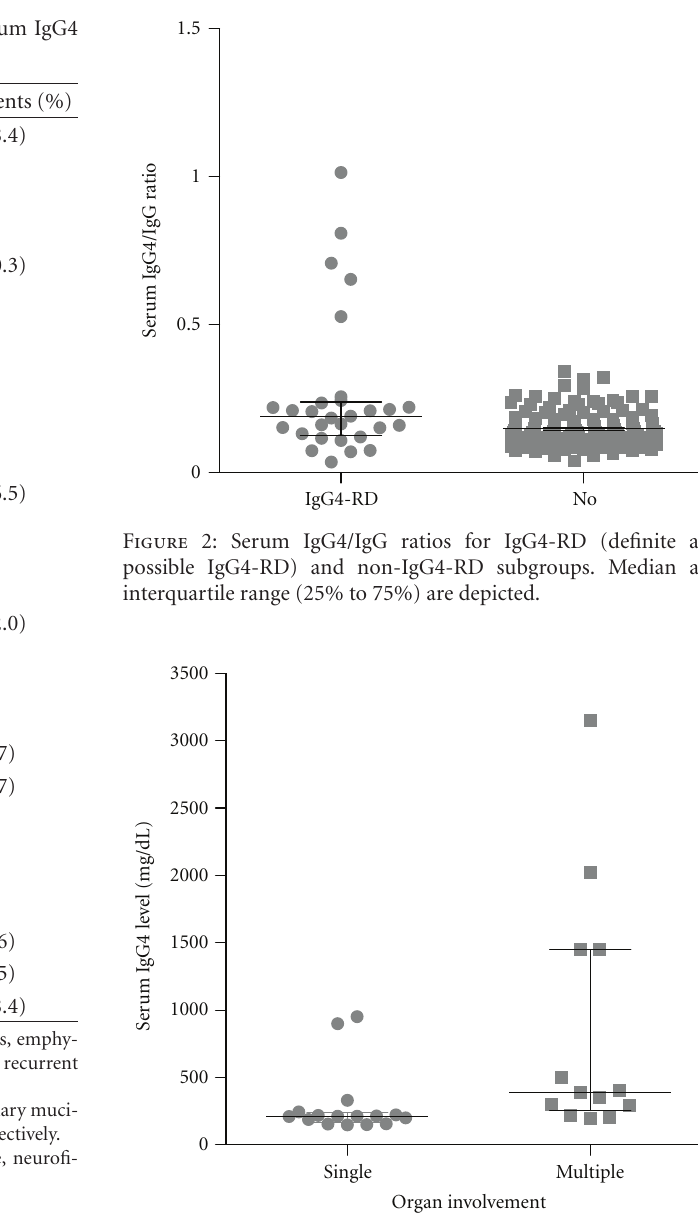
Figure 3: Serum IgG4 levels for patients with single-organ and multiple-(two or more) organ involvement. Median and interquar- tile range (25% to 75%) are